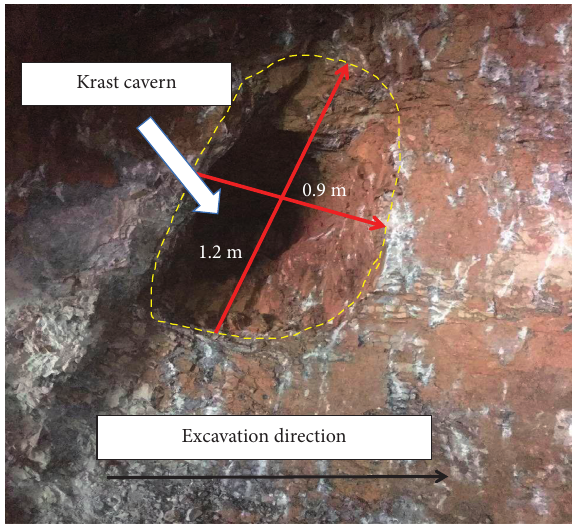
Figure 2: Karst caverns at the top of the right lane cave of the Hebai